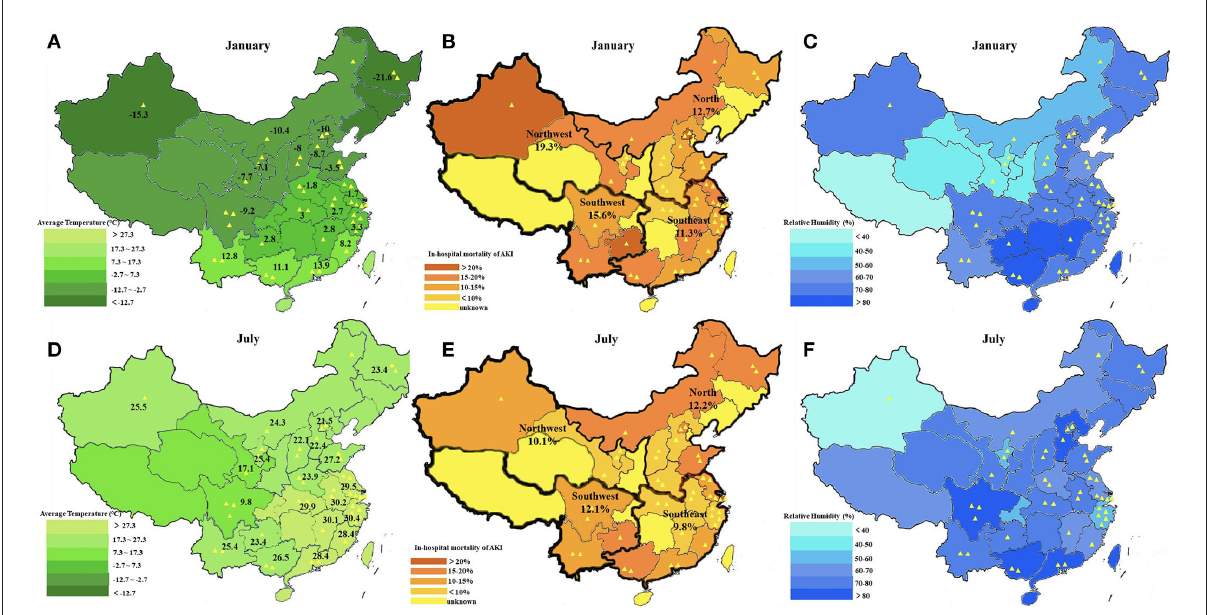
FIGURE3 Map of monthly average temperature and relative humidity level in January and July 2013 across different cities in China. (A) The monthly average temperature in January; (B) In-hospital mortality of patients with AKI in January; (C) The relative humidity level in January; (D) The monthly average temperature in July; (E) In-hospital mortality of patients with AKI in July; and (F) The relative humidity level in July. Each yellow triangle represents a study hospital.